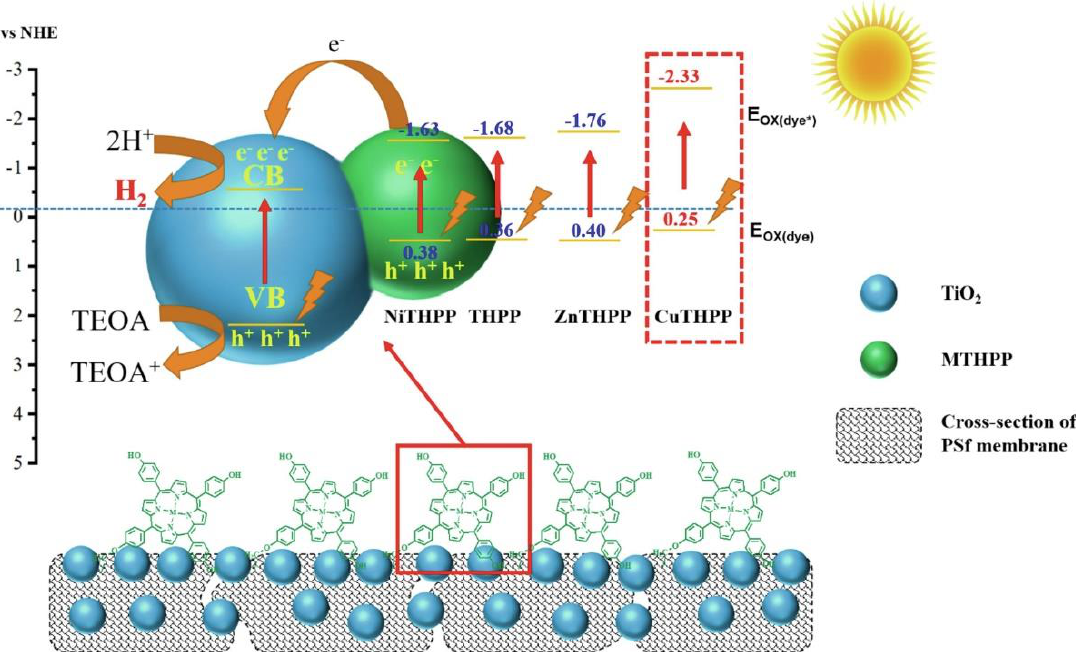
Figure 4. Photocatalytic hydrogen production mechanism: electrons generated by photoexcitation of MTHPP through visible light and TiO 2 through UV light, enriching the CB of TiO 2 , which promotes the reduction of H 2 O to H 2 (E H2/H2O = − 0.41 eV vs. NHE). Holes (h + ) on the membrane surface are consumed by TEOA, preventing the recombination of photogenerated e − and h + . Reproduced from reference [53] with permission from Elsevier, copyright 2022.